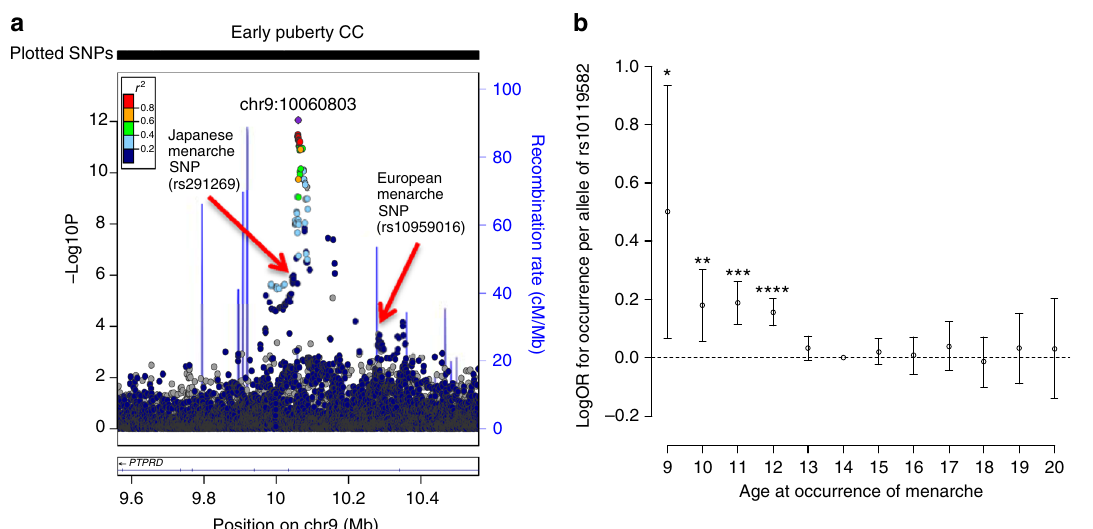
Fig. 2 Disproportionate effects on early vs. late puberty for rs10119582 at the PTPRD locus. a Regional association plot for the early puberty model in Japanese. b Effect of rs10119582 at the PTPRD locus on risk of speci fi c ages at menarche. Each point represents the natural log of the odds ratio per + 1 ‘ T ’ allele at rs10119582 for being in that menarche age category compared to the reference group (menarche at age 14 years). Error bars represent the 95% con fi dence intervals around this estimate. * P = 0.02, ** P = 0.004, *** P = 6.4 × 10 − 7 , **** P = 1.3 × 10 −